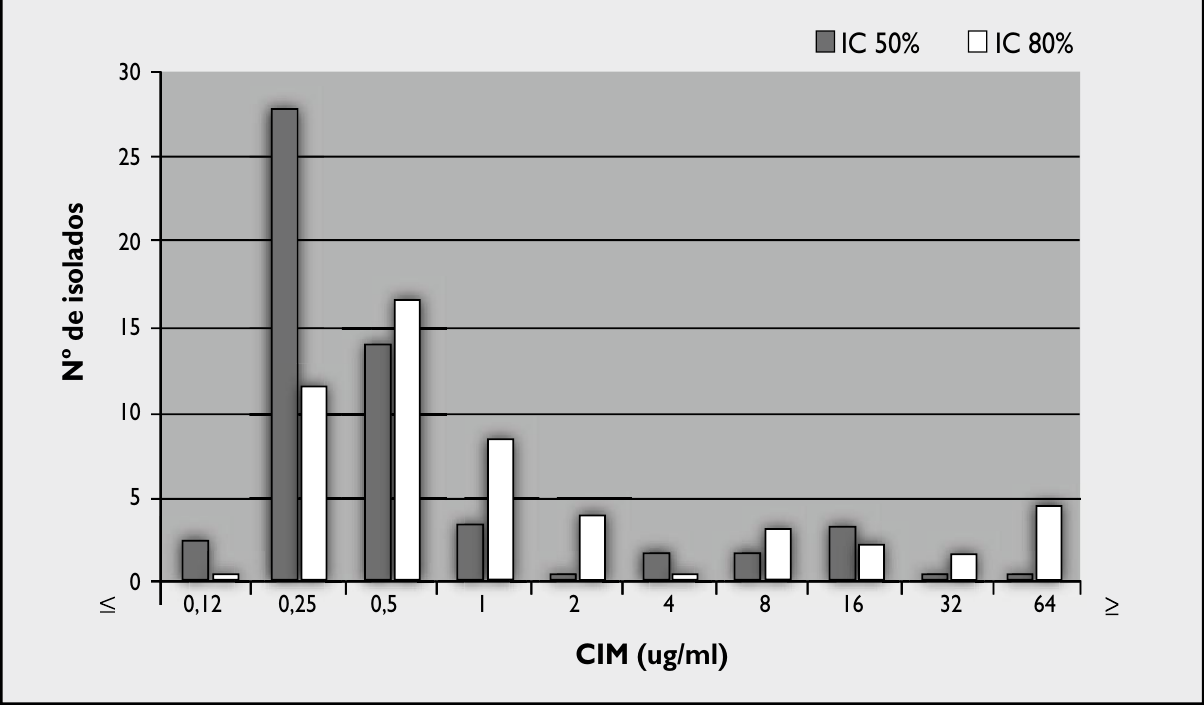
Figura 1 – Distribuição dos valores de concentração inibitória mínima (CIM) de fl uconazol, calculados com índice de inibição de 50% e 80%, em isolados de Candida